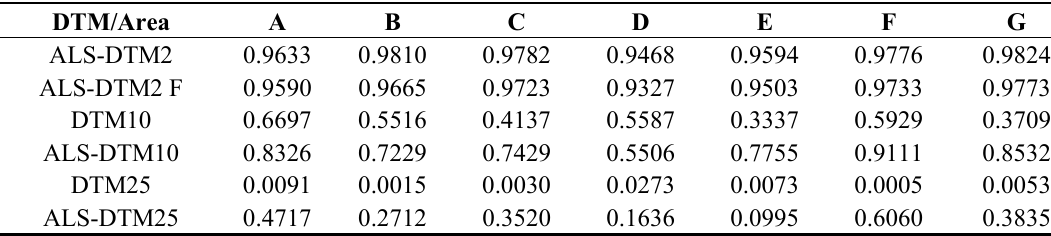
Table 3. R 2 values of fitted regression lines of scatter plots representing DTM elevations versus reference elevations. Scatter plots with fitted linear regression lines were used for the Nash-Sutcliffe model efficiency coefficient (NSE) evaluation, as recommended by [63–65], because of the high extreme values that could affect the NSE because of the squared